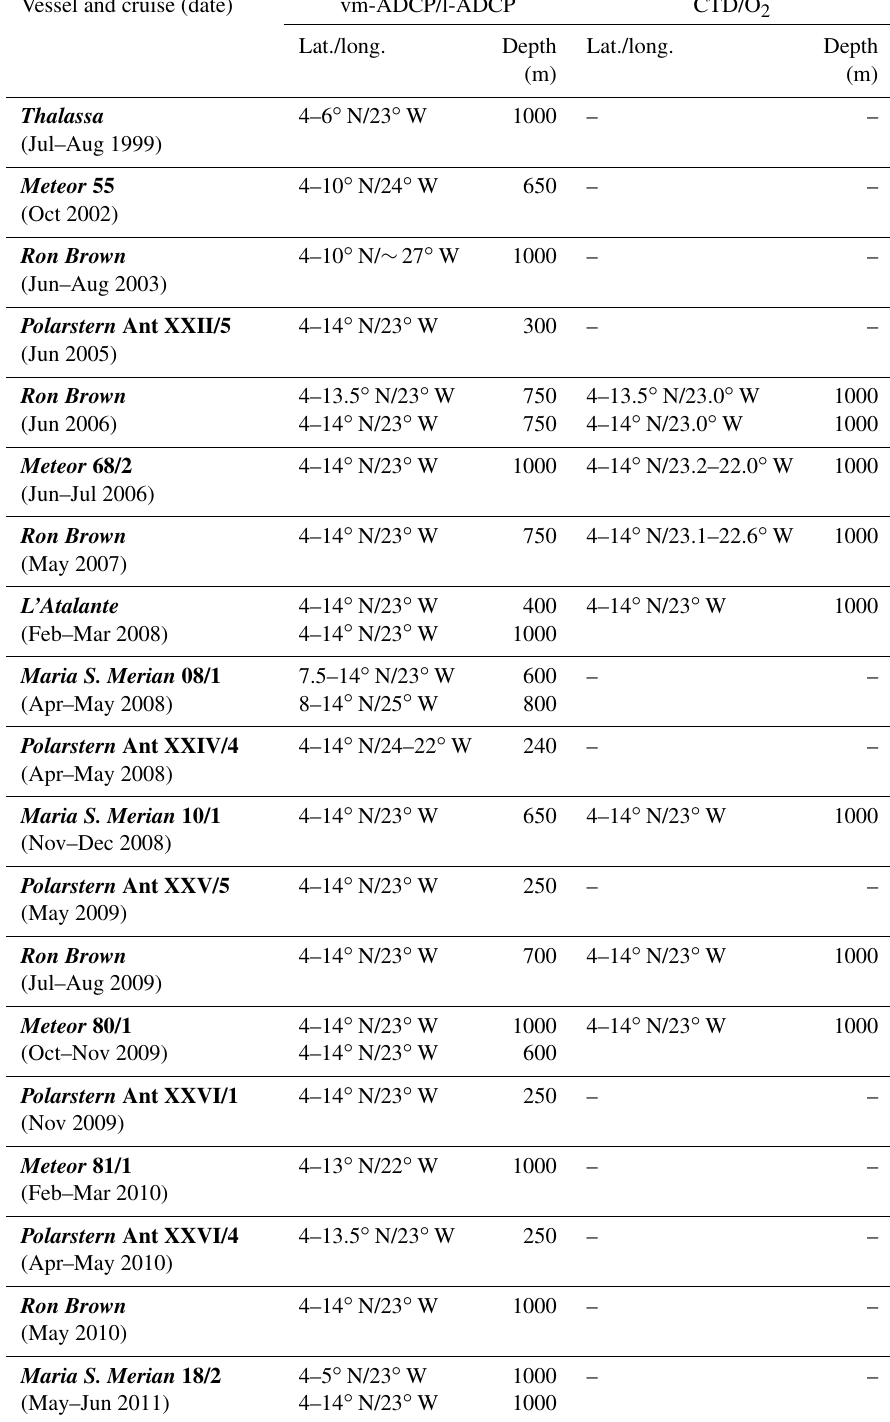
Table 1. Research cruises carried out in the eastern tropical North Atlantic between 4 and 14 ◦ N mainly along the 23 ◦ W section between 1999 and 2015. Different columns denote the latitude section along mean longitude (lat./long.) and maximum profile depth available/used here (depth in meters) for velocity observations performed with vessel-mounted and lowered Acoustic Doppler Current Profilers (vm-ADCPs/l- ADCPs) as well as for hydrographic and oxygen observations performed with a conductivity–temperature–depth sonde (CTD/O 2 ) . Note that during some research cruises, two velocity and/or hydrographic sections were